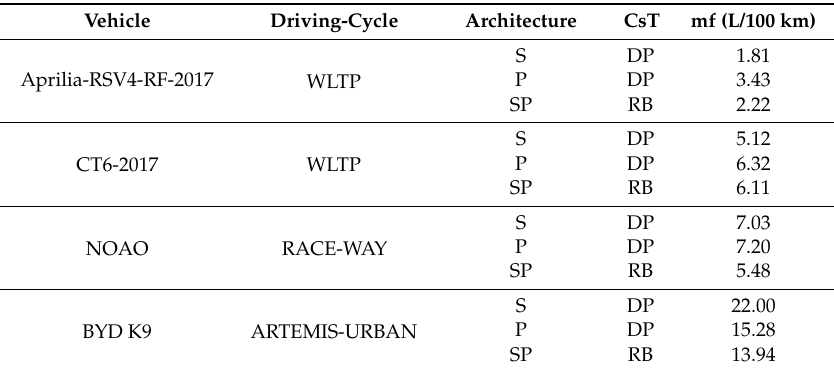
Table 2. Results of fuel consumption for 100